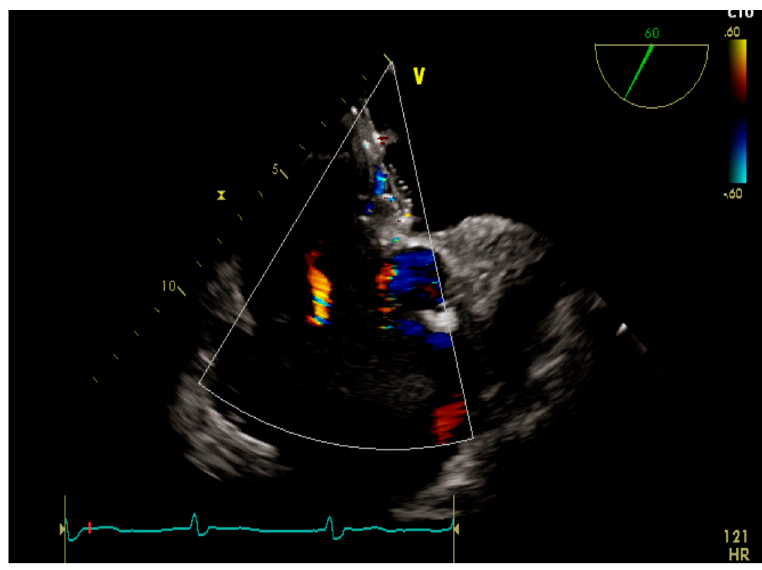
Figure 3. Transesophageal echocardiography showing the fenestrated device.